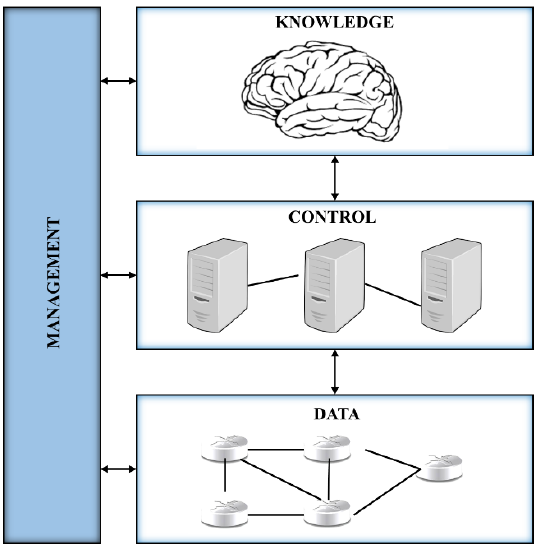
Figure 1. SDN-with-Knowledge plane.